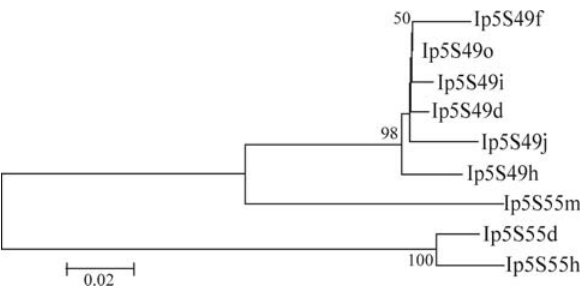
Figure 3 - Neighbor-joining three based on the 5S rDNA nucleotide se- quences of Isopisthus parvipinnis . The numbers at each node indicate the